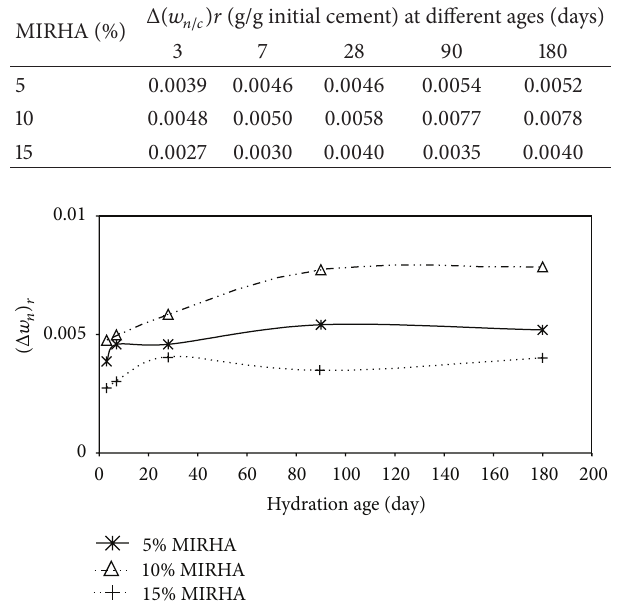
Figure 4: Δ𝑤 𝑛/𝑐 due to the presence of MIRHA using OD/FI